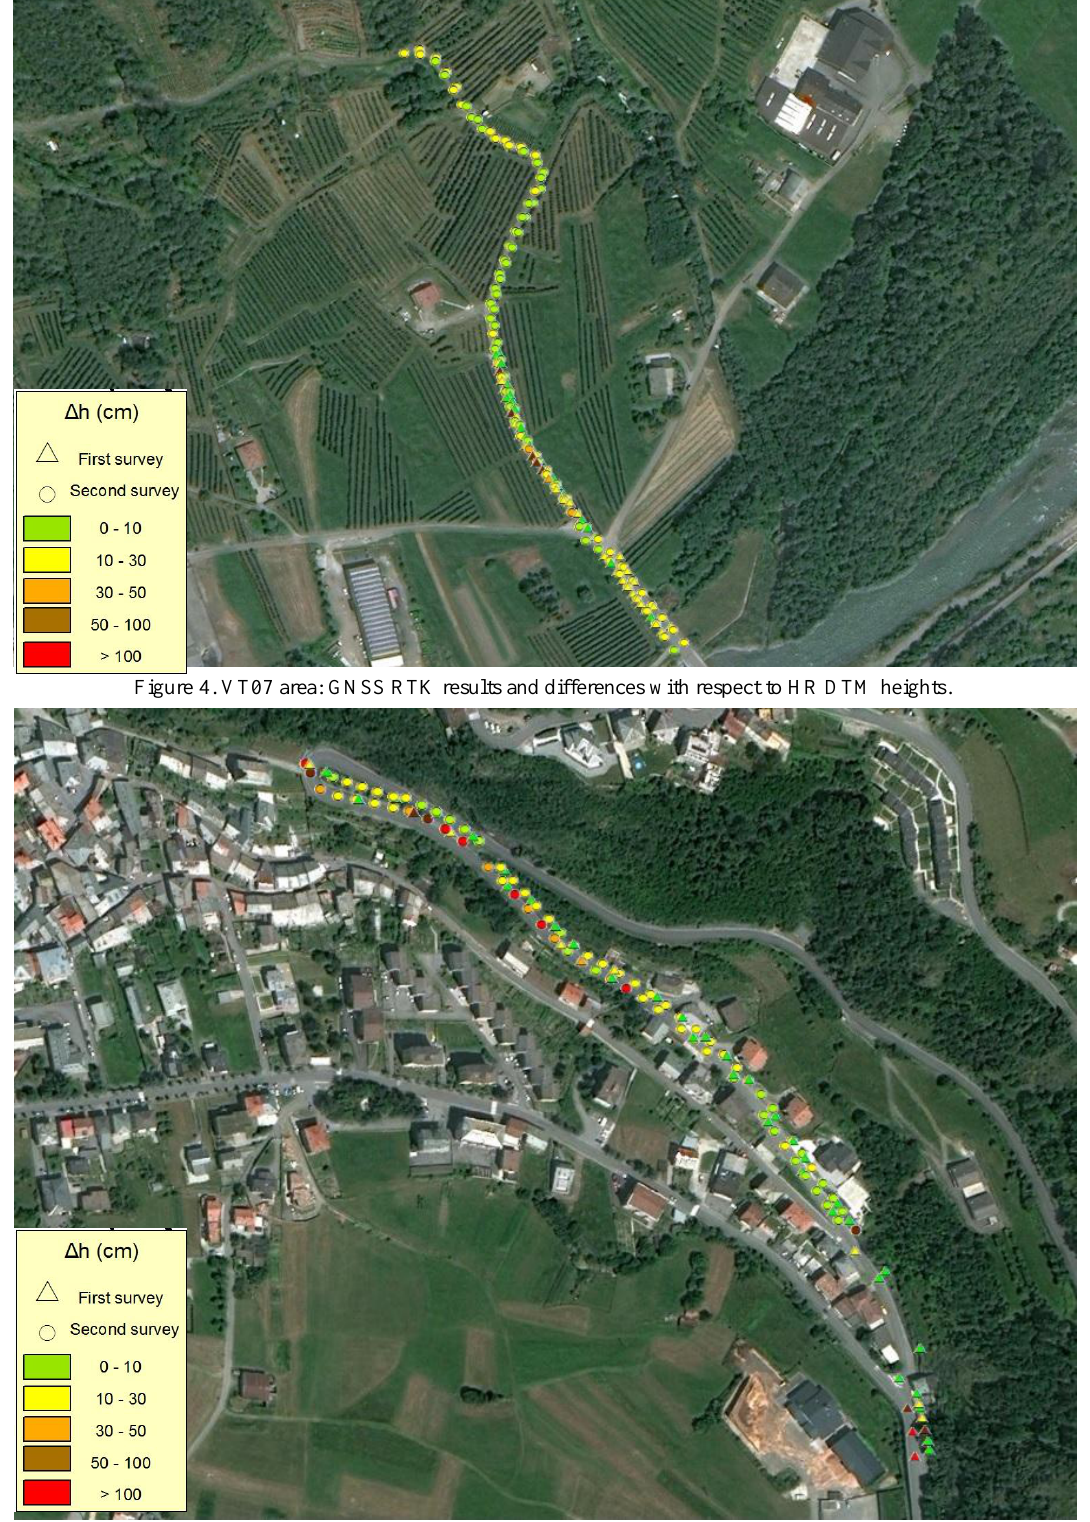
Figure 5. VT10 area: GNSS RTK results and differences with respect to HR DTM